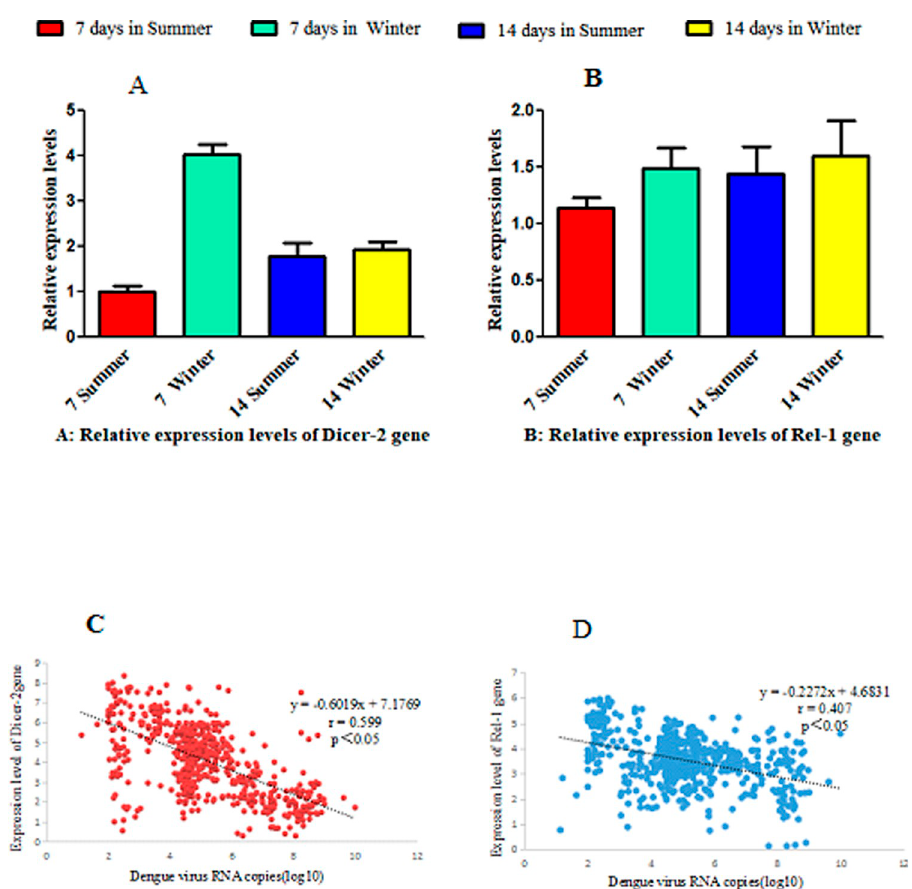
Fig 9. Correlations between DENV-2 loads and the expression levels of immune- associated genes [ Dicer-2 , Rel2 ] in the midguts of Ae . albopictus at 7 and 14 days after dengue virus infection in different seasons. (A) Dicer-2 gene expression levels. (B) Rel-1 gene expression levels. (C) Correlations between DENV-2 loads and Dicer-2 gene expression levels. (D) Correlations between DENV-2 loads and Rel-1 gene expression